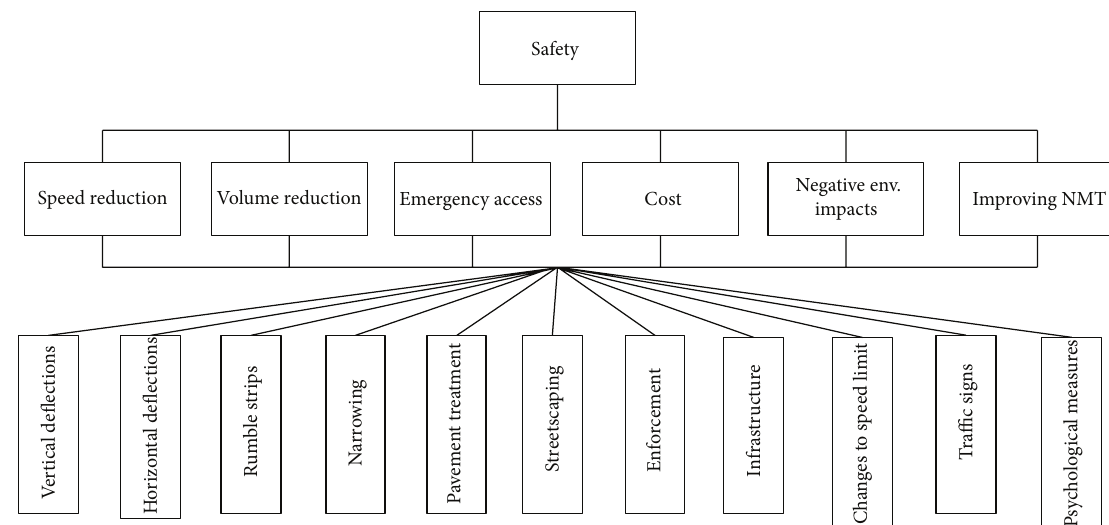
Figure 2: Hierarchical structure of the model.